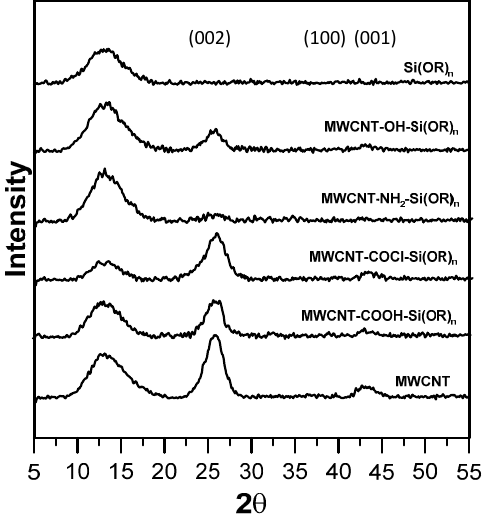
Figure 4. XRD patterns of MWCNT-grafted silica nanohybrids.